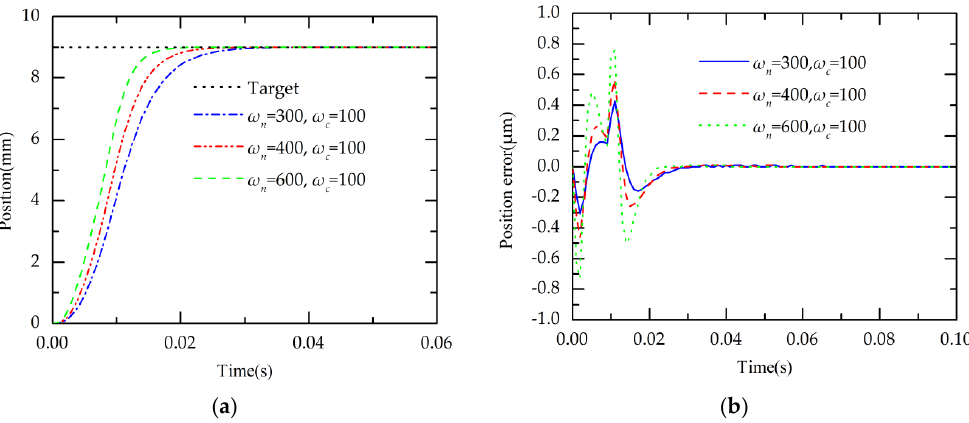
Figure 7. Simulation results of the proposed controller with the different parameter ω c , when the parameter ω n = 300: ( a ) Position; and ( b ) Position error.